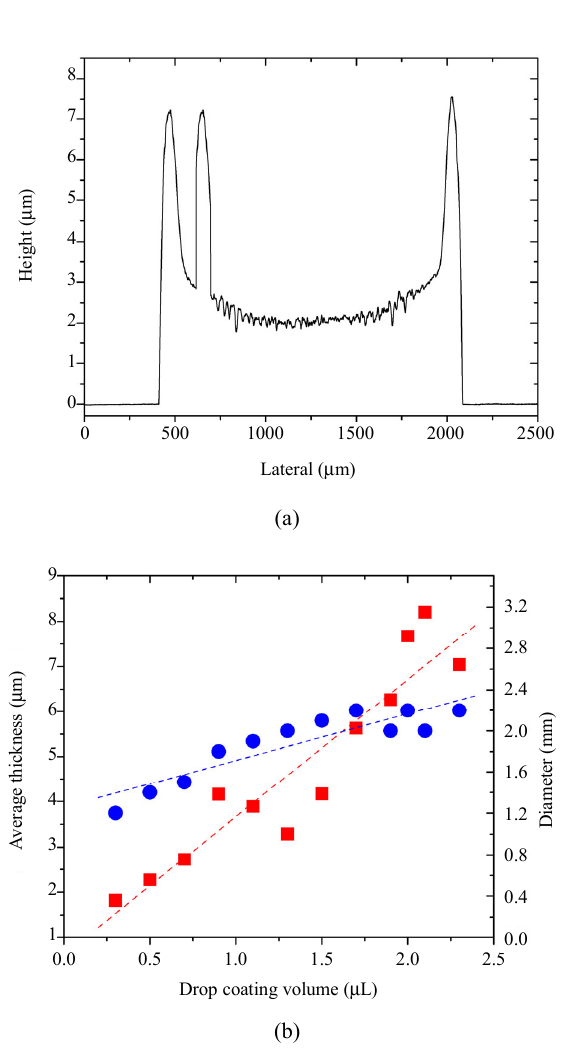
Fig. 4 SnO 2 film: (a) surface profile obtained from Dektak D150 with drop coating volume of 0.5 μ L and (b) effect of drop coating volume to the average thickness and diameter of SnO 2 coating at three times drop process.